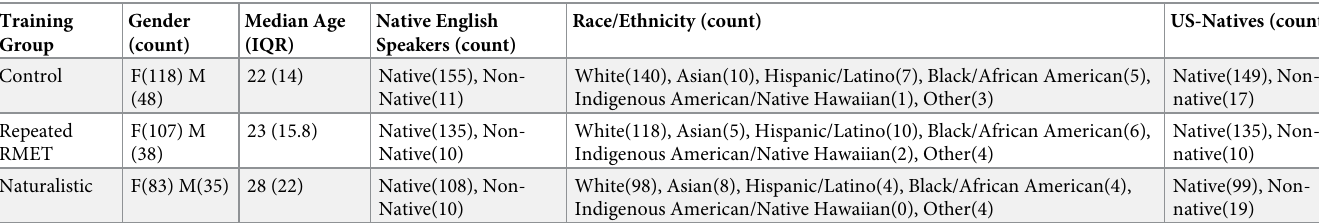
Table 1. Demographics of participants per condition.